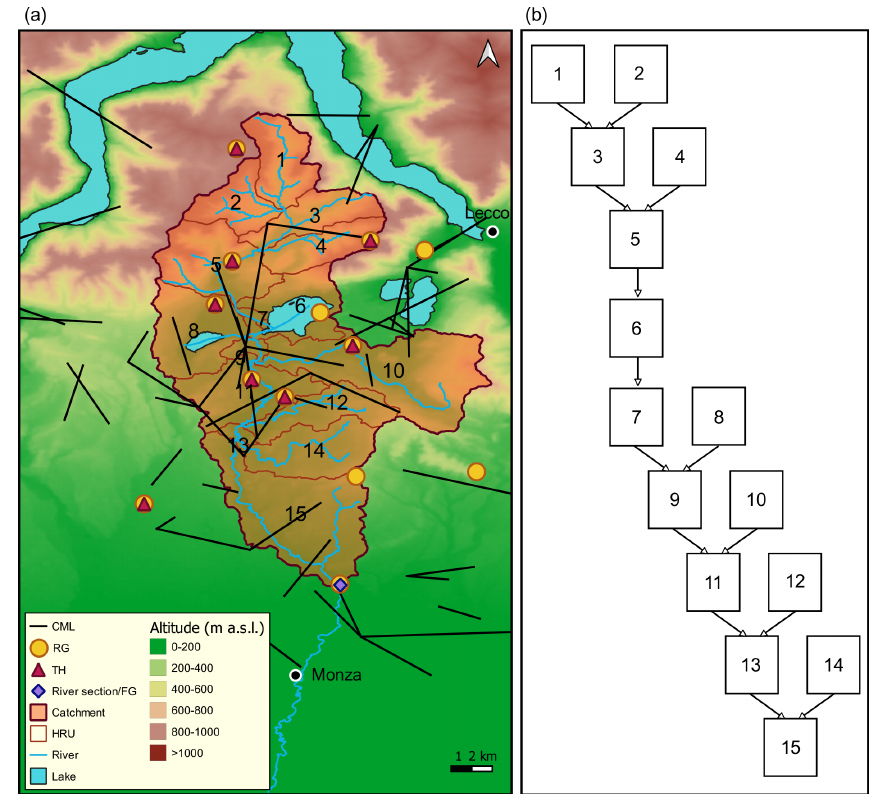
Figure 1. Case study area: panel (a) shows the Lambro Catchment, the partitioning into 15 sub-basins (HRUs), and the position of the sensors; panel (b) reports the scheme of HRU interaction in the network. Please note that FG is the flow gauge located at the outlet section. The digital terrain model (DTM) is freely available at https://www.geoportale.regione.lombardia.it (last access: 10 March